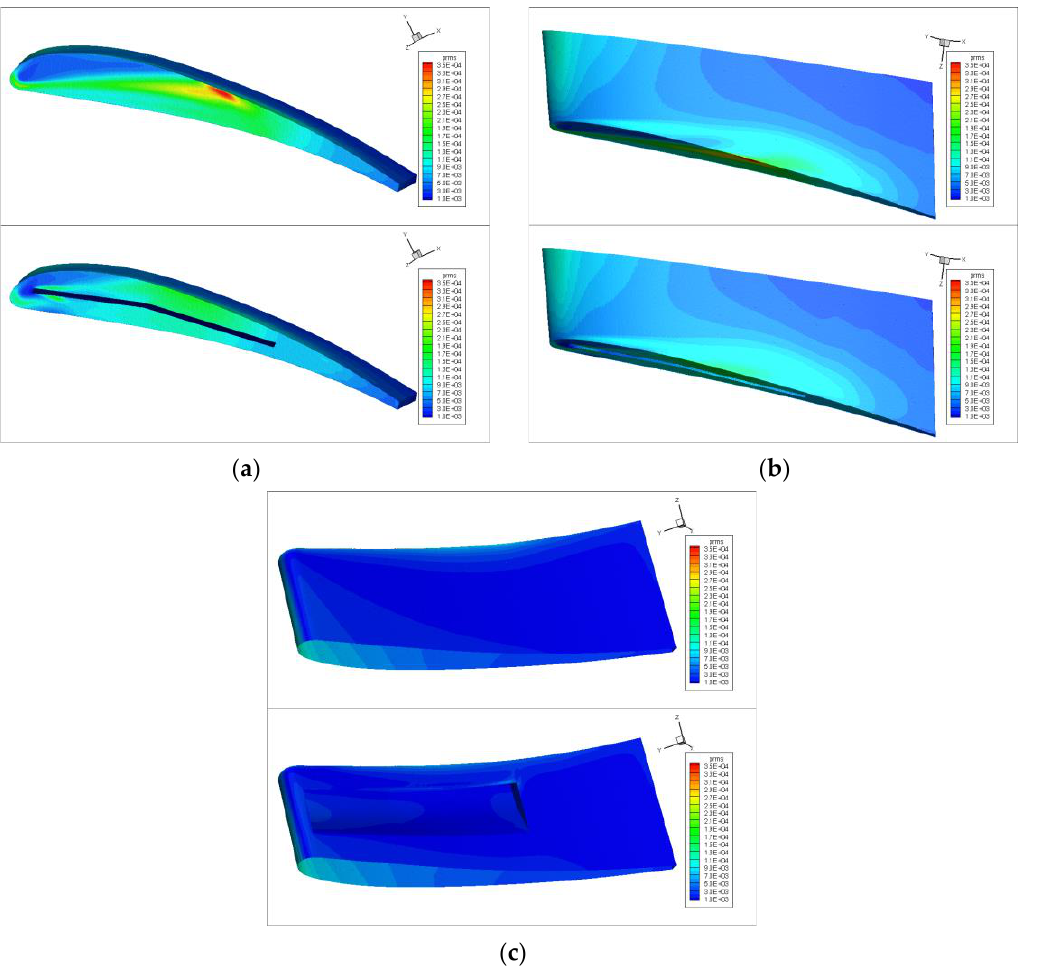
Figure 8. The comparison of the RMS pressure distribution around the flap side-edge between the baseline flap side-edge and the slotted flap side-edge. ( a ) Side view; ( b ) top view; ( c ) bottom view.